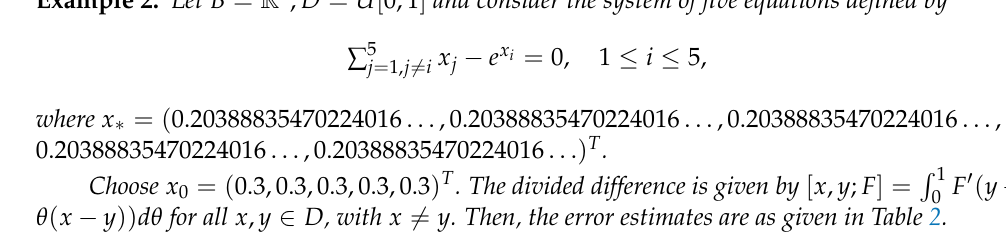
Table 2. Error estimates for Example